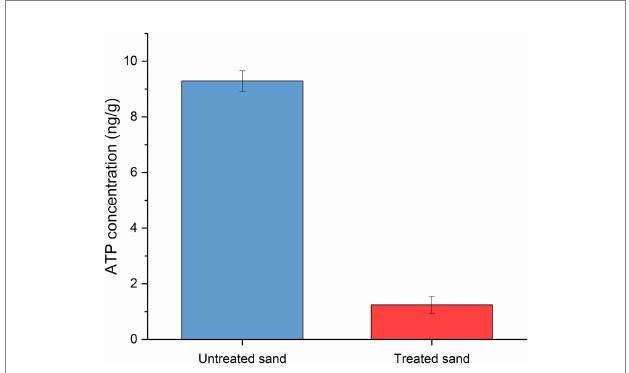
FIGURE 6 Adenosine triphosphate (ATP) concentration of biofilms growth within two different sand deposits in the UDC reactors after 4 weeks of